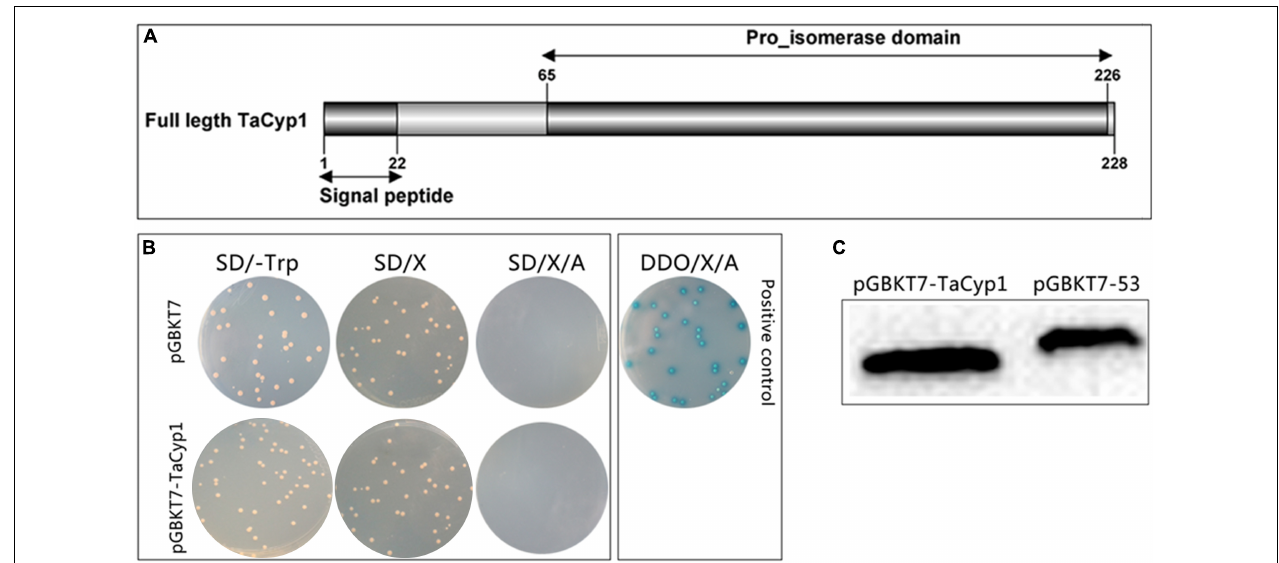
FIGURE 1 | Gene structure, expression, auto-activation, and toxicity tests for pGBKT7-TaCyp1. (A) Gene structure of TaCyp1, the whole length (aa1-228) of TaCyp1 was used in yeast-two-hybrid screening. (B) Western blot analysis of total proteins extracted from Y2HGold cells. TaCyp1 bait protein and positive control were 45 and 57 kDa in size, respectively. (C) Analysis of auto-activation and toxicity activity of pGBKT7-TaCyp1 bait plasmid in Y2HGold cells. The pGBKT7- TaCyp1 bait and pGBKT7 plasmids were transformed to Y2HGold cells and the transformants were grown on SD, SD/X, and SD/X/A agar plates, respectively; the co-transformants containing pGADT7-T and pGBKT7-53 were grown on DDO/X/A agar plates as positive